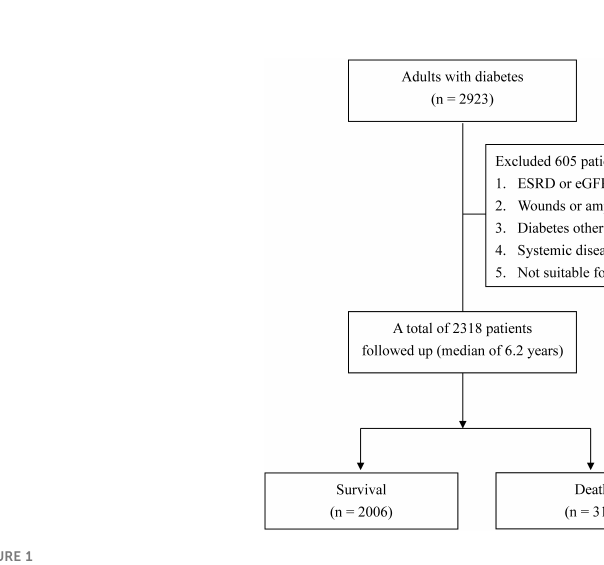
FIGURE 1 Flow diagram of the enrollment process for study subjects.